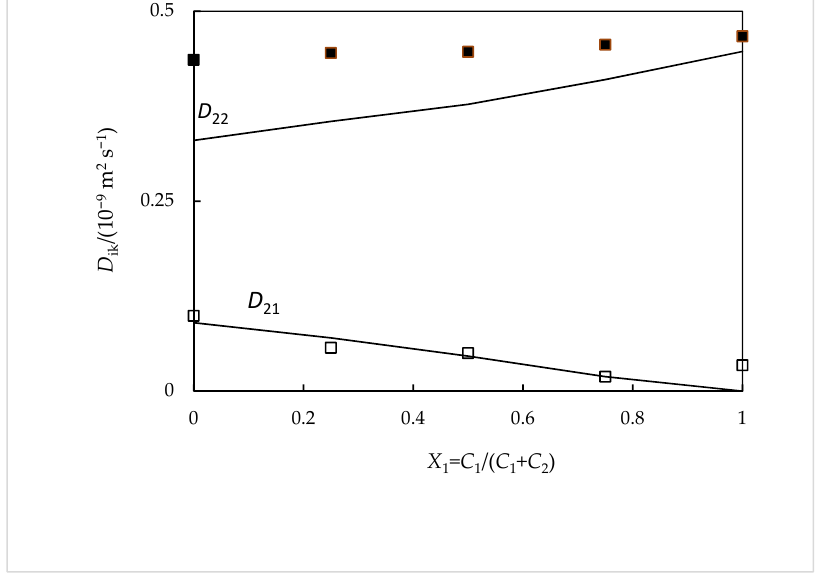
Figure 4. Ternary D ik coefficients for NaSal( C 1 ) + β -CD ( C 2 ) aqueous solutions containing 0.010 mol dm − 3 of total solute compared with the corresponding values calculates from Nernst equations: D 21 , hollow squares; D 22 , filled squares. The solid curves correspond to the values calculated from the Nernst equations [22].